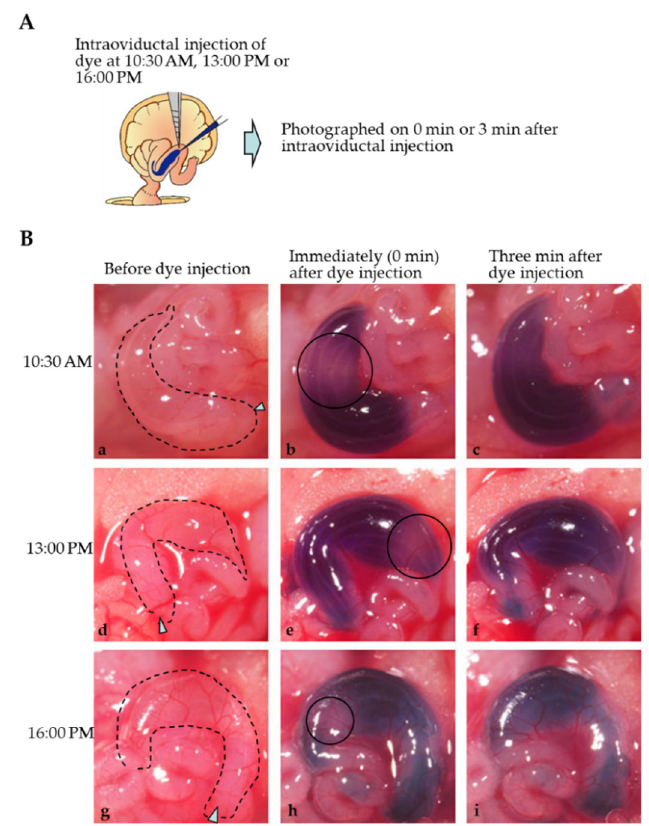
Figure 3. Monitoring of the solution intraoviductally injected using dye (Fast Green FCF). ( A ). Schematic representation of intraoviductal injection of dye at various times (10:30 a.m., 13:00 p.m. and 16:00 p.m.) on the day when vaginal plug are discerned for checking the mode of dye distribution at the